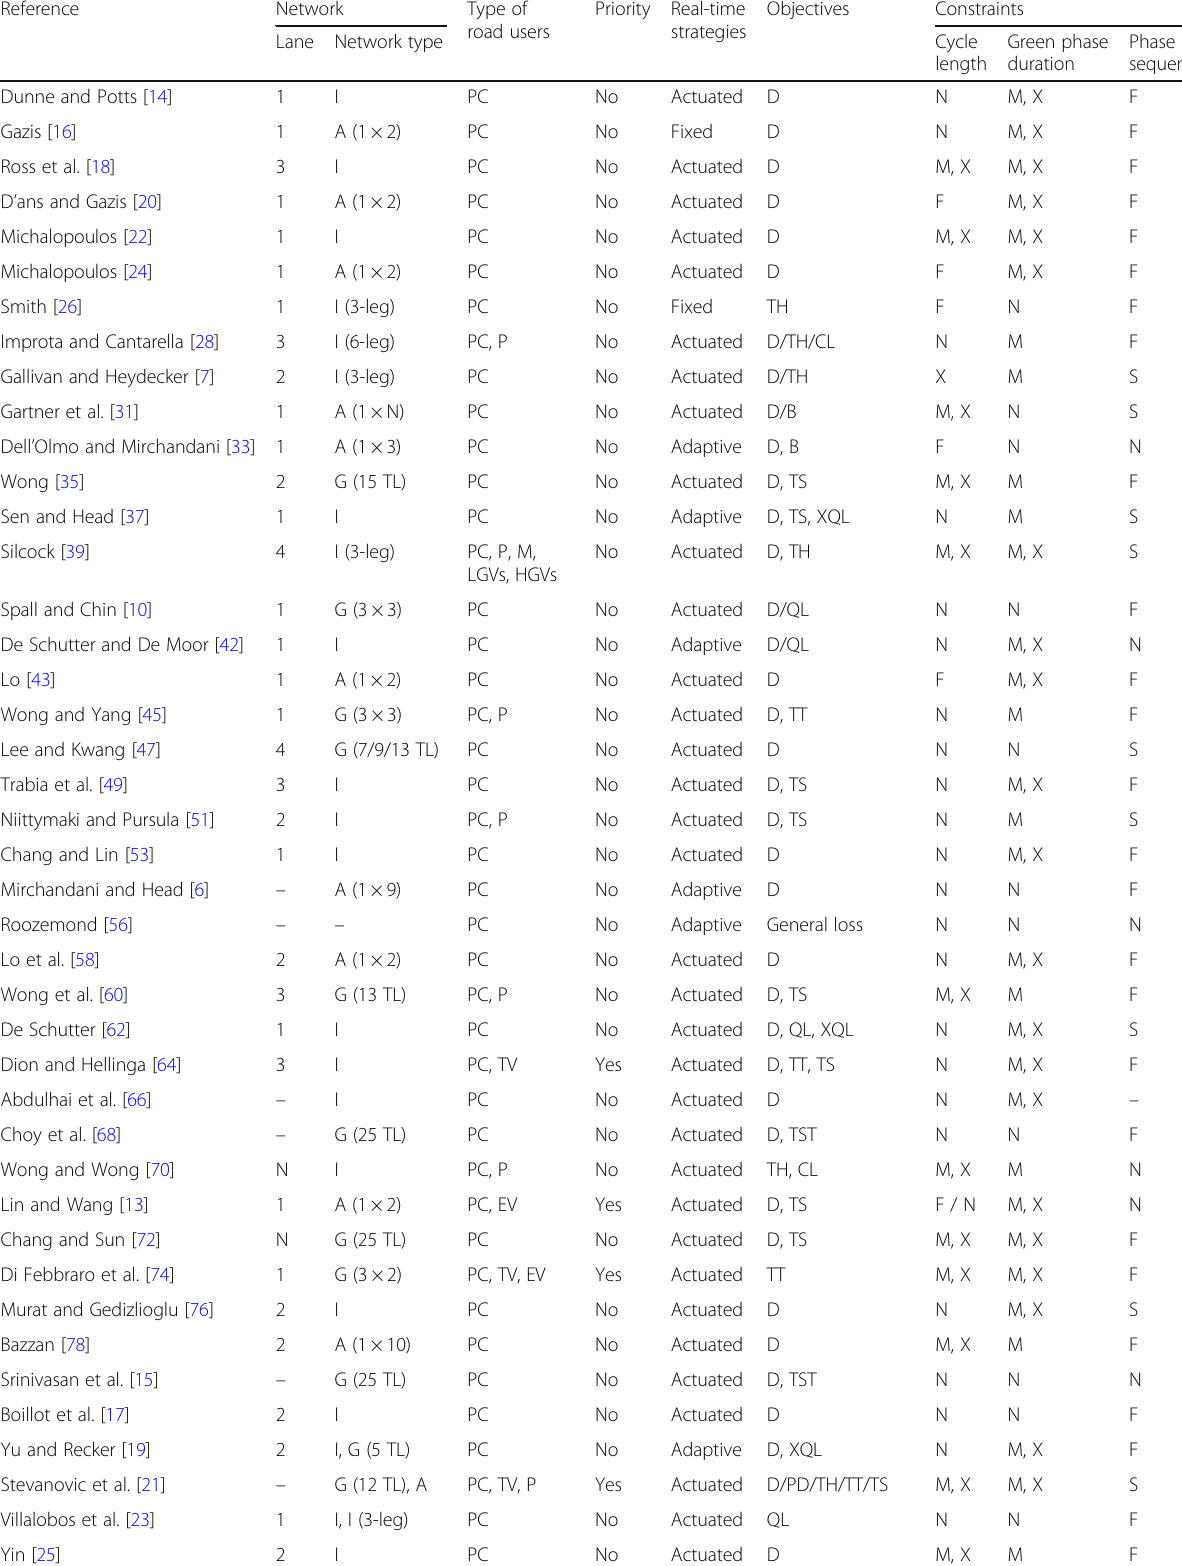
Table 3 Literature classification based on problem